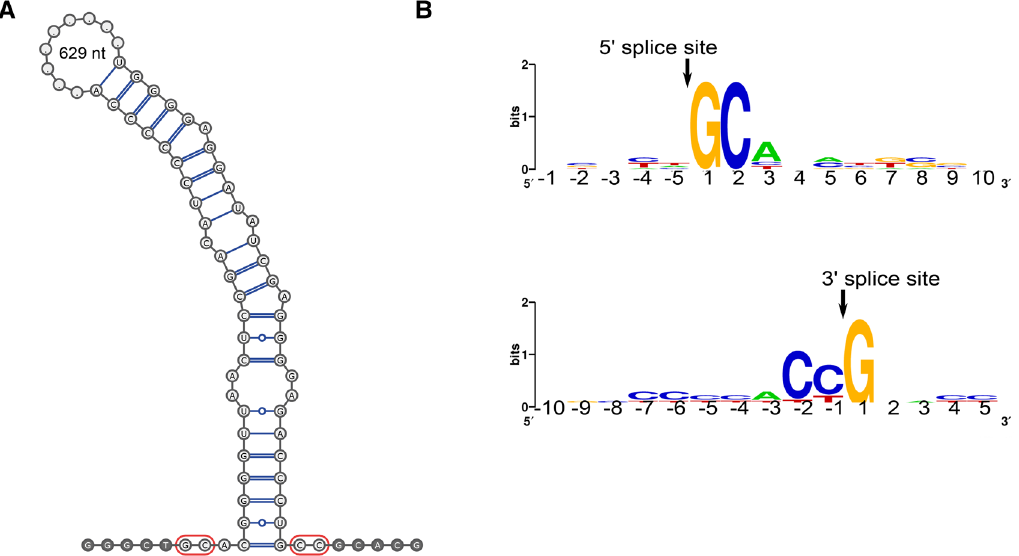
Figure 4. Example of the nonconventional intron of R. costata . The secondary structure of a nonconventional intron from NODE_718 ( A ), and the sequence logo of the boundaries of seven putative nonconventional introns detected in R. costata ( B